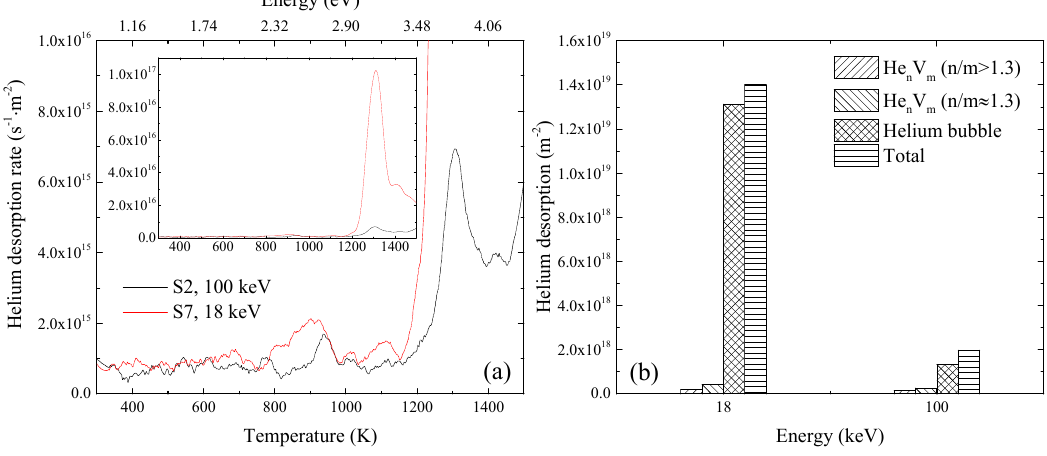
Figure 9. ( a ) Desorption spectra in specimens irradiated with 100 keV ‐ He + and 18 keV ‐ He + at 523 K to 1 × 10 20 m − 2 ; ( b ) amounts of helium released from various defect clusters, and total helium amount released in specimens irradiated with 100 keV ‐ He + and 18 keV ‐ He + at 523 K to 1 × 10 20 m − 2 .